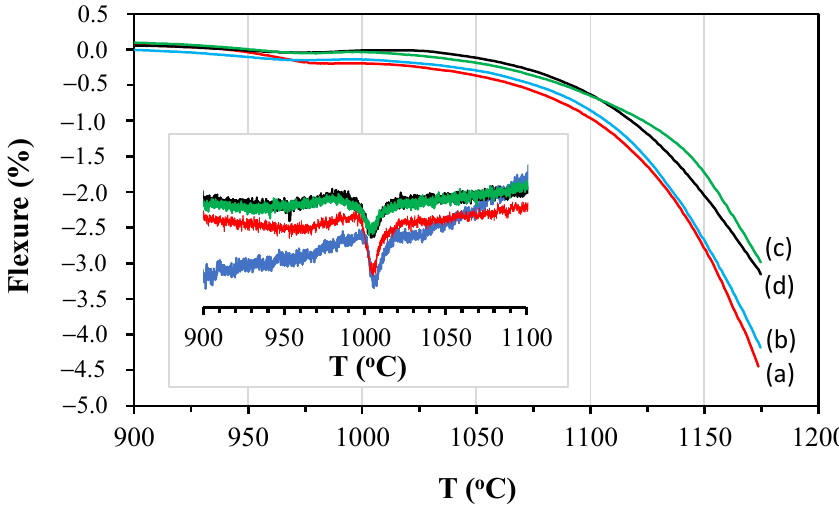
Figure 12. Optical fleximetry of studied compositions: (a) C0; (b) C1; (c) C2; (d) C3. Highlighted DSC plot: C0—blue line; C1—red line; C2—black line; C3—green line.